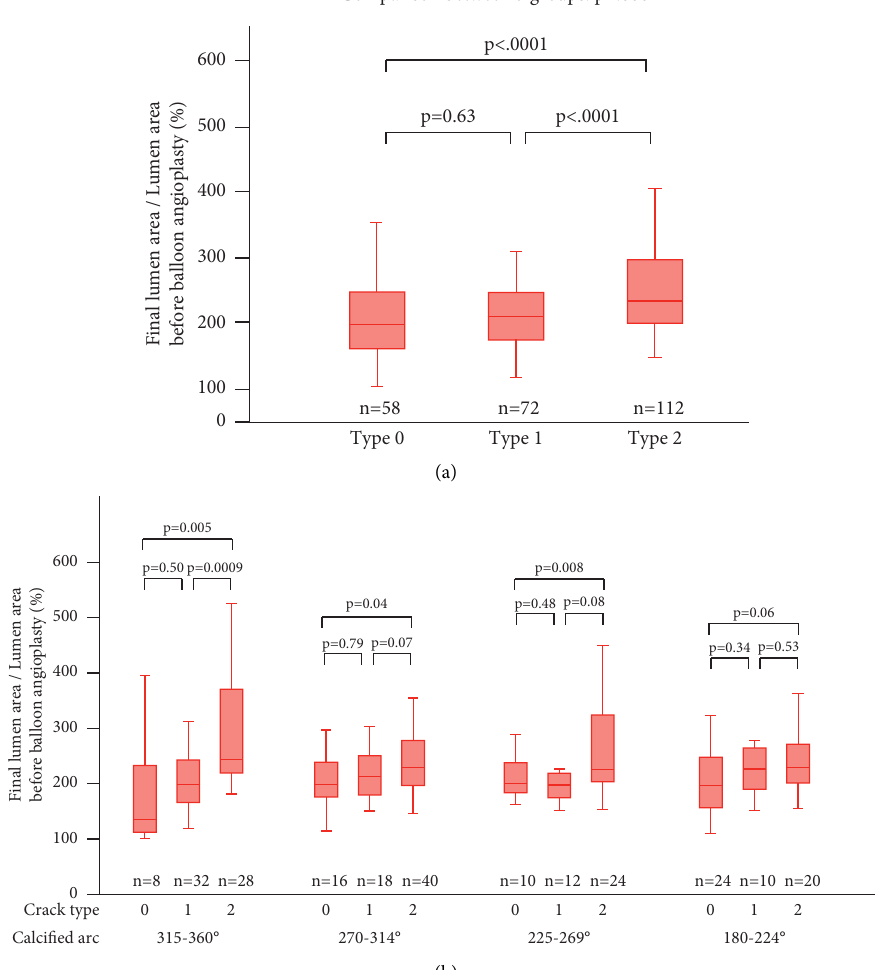
Figure 2: Lumen area expansion ratio between before ballooning and after stenting. (a) Lumen area expansion ratio between before ballooning and after stenting (all analyzed frames ( n � 242)). Type 0, 196% (interquartile range (IQR), 163–244), type 1, 210% (IQR, 174–244), and type 2, 237% (IQR, 203–294). (b) Lumen area expansion ratio between before ballooning and after stenting according to